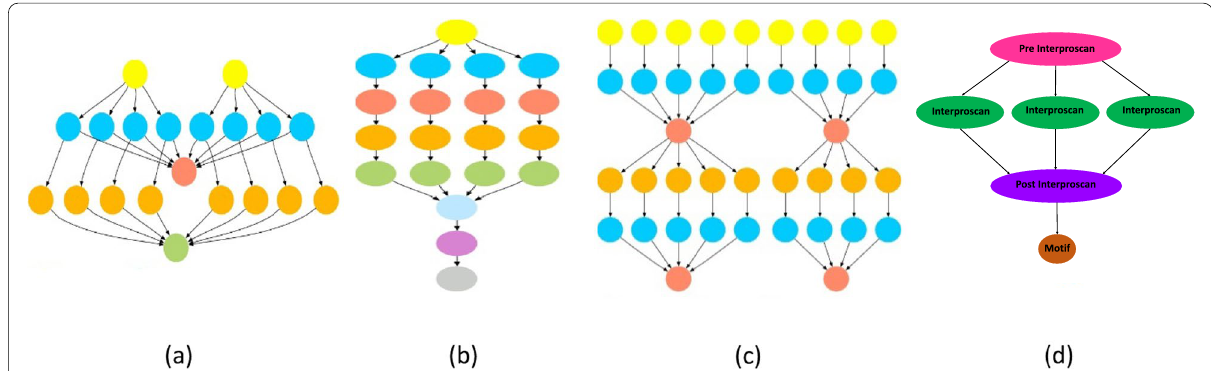
Fig. 10 Structure of the examined workflow [54]. a CyberShake. b Epigenomics. c LIGO. d